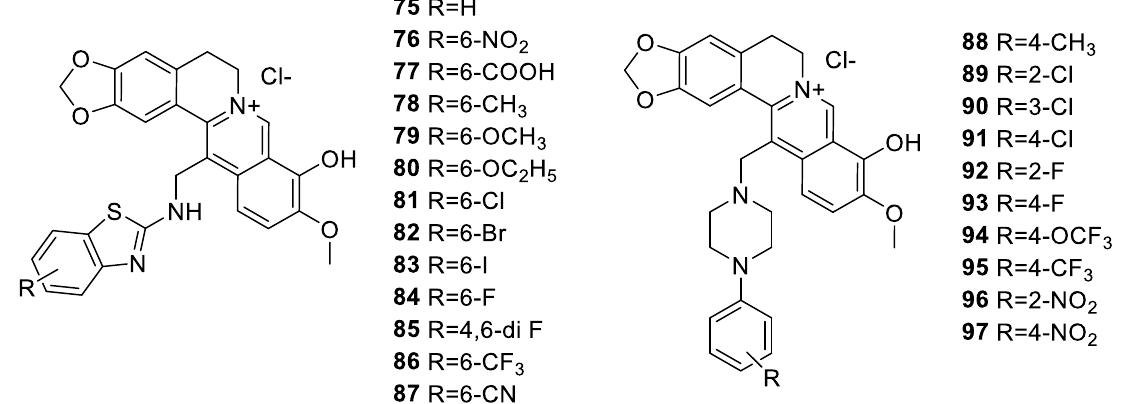
Figure 10. N -Mannich base berberine derivatives.